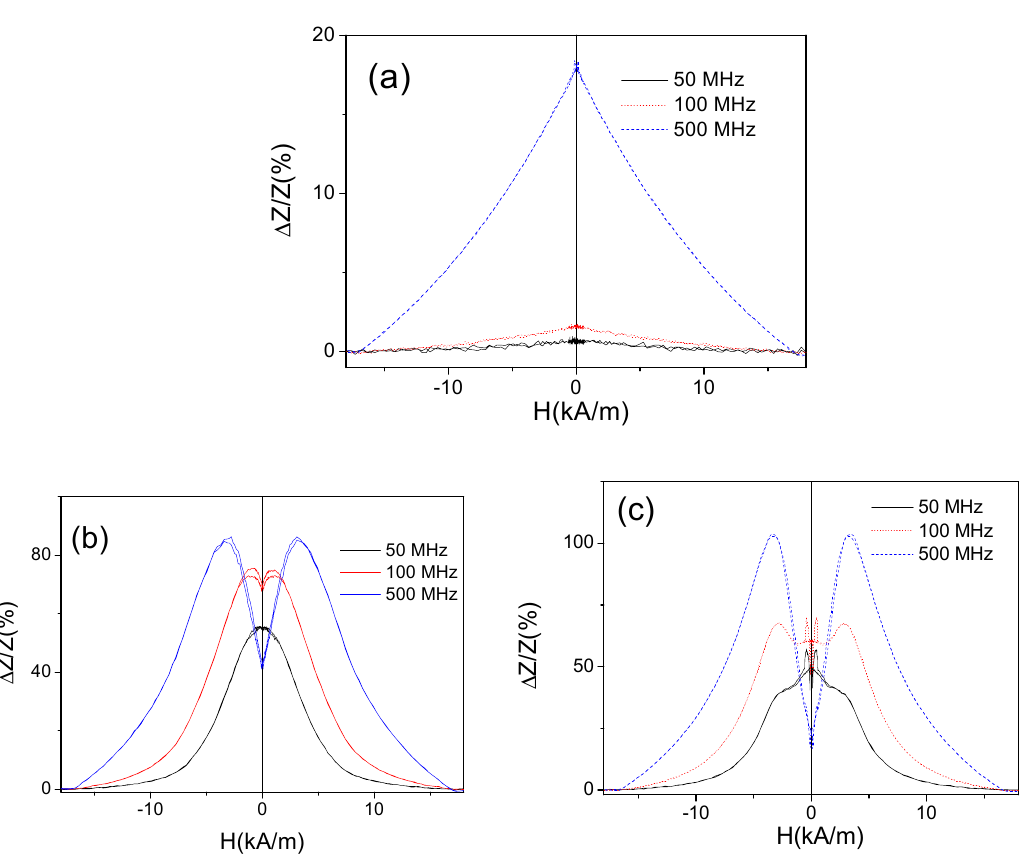
Figure 4. Δ Z/Z (H) dependencies of as-prepared ( a ); stress-annealed at T ann = 300 °C for σ a = 390 MPa ( b ) and for σ a = 900 MPa ( c ) Fe 75 B 9 Si 12 C 4 microwires. ( b ) and for σ a = 900 MPa ( c ) Fe 75 B 9 Si 12 C 4